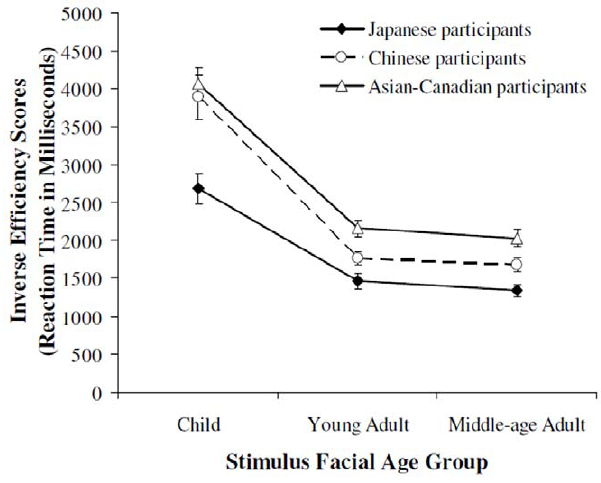
Figure 2. Participants’ adjusted reaction time (i.e., inverse efficiency scores) in age judgments for child, young adult, and middle-age adult faces.